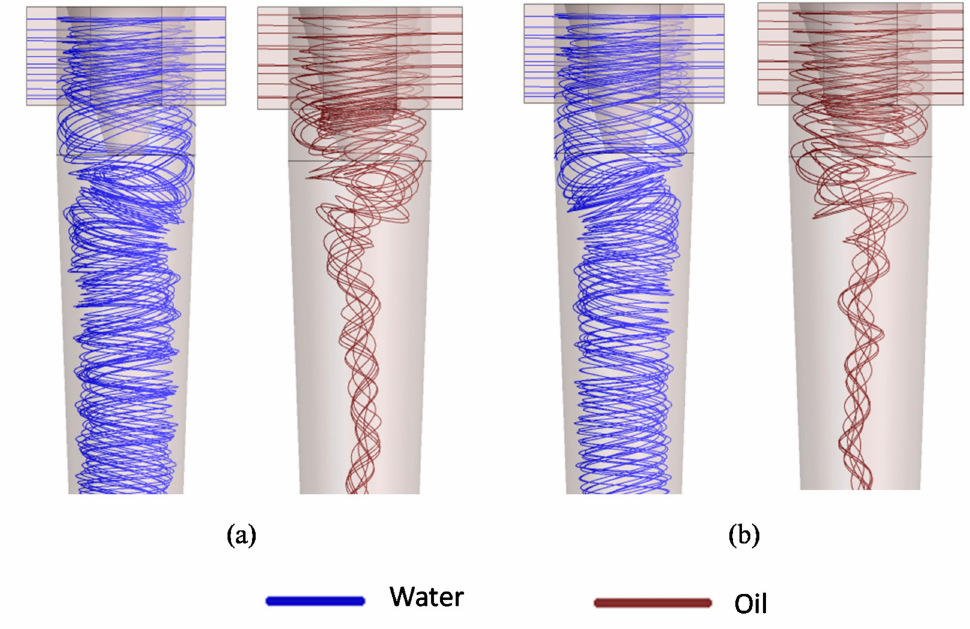
Figure 12. Water and oil streamlines inside the filtering cyclonic separator: ( a ) R = 0.96 and ( b ) R = 1.00, with δ p = 7.82 × 10 − 2